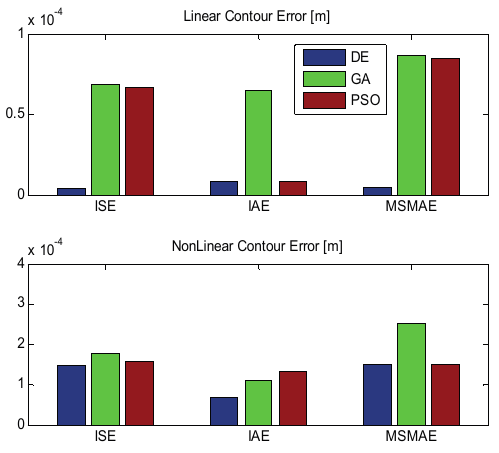
Figure 4. Contour errors produced by the optimized gains.